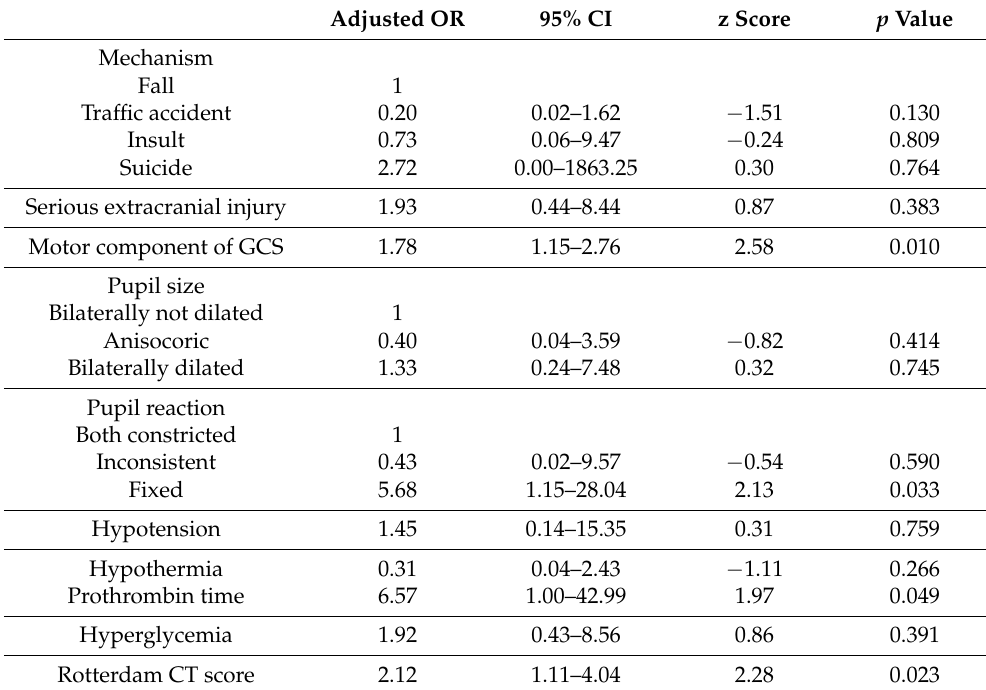
Table 3. Multivariate predictive models for mortality in children with severe traumatic brain